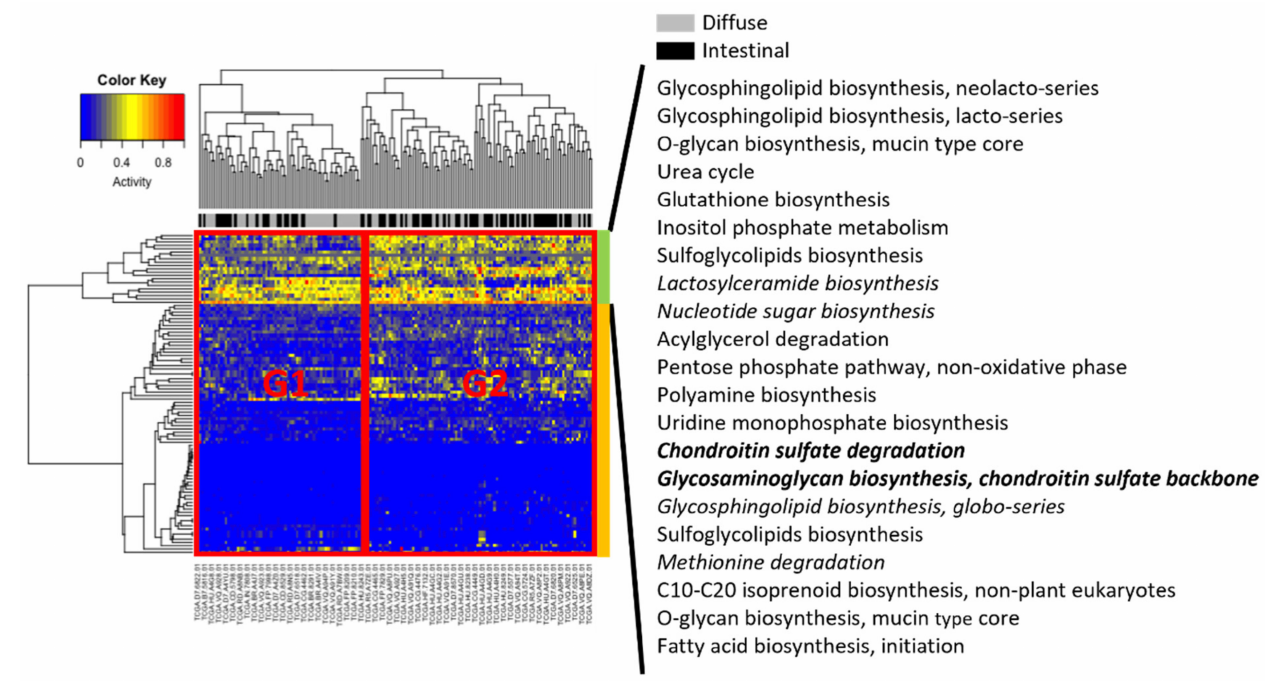
Figure 4. Metabolizer revealed differential activities between diffuse and intestinal subtypes in the TCGA. Columns indicate TCGA patients, and rows indicate activities of metabolic modules calculated by Metabolizer. The modules in italics indicate upregulation in diffuse versus intestinal subtypes, and the modules in italics and bold indicate statistically significant upregulation (adjusted p <